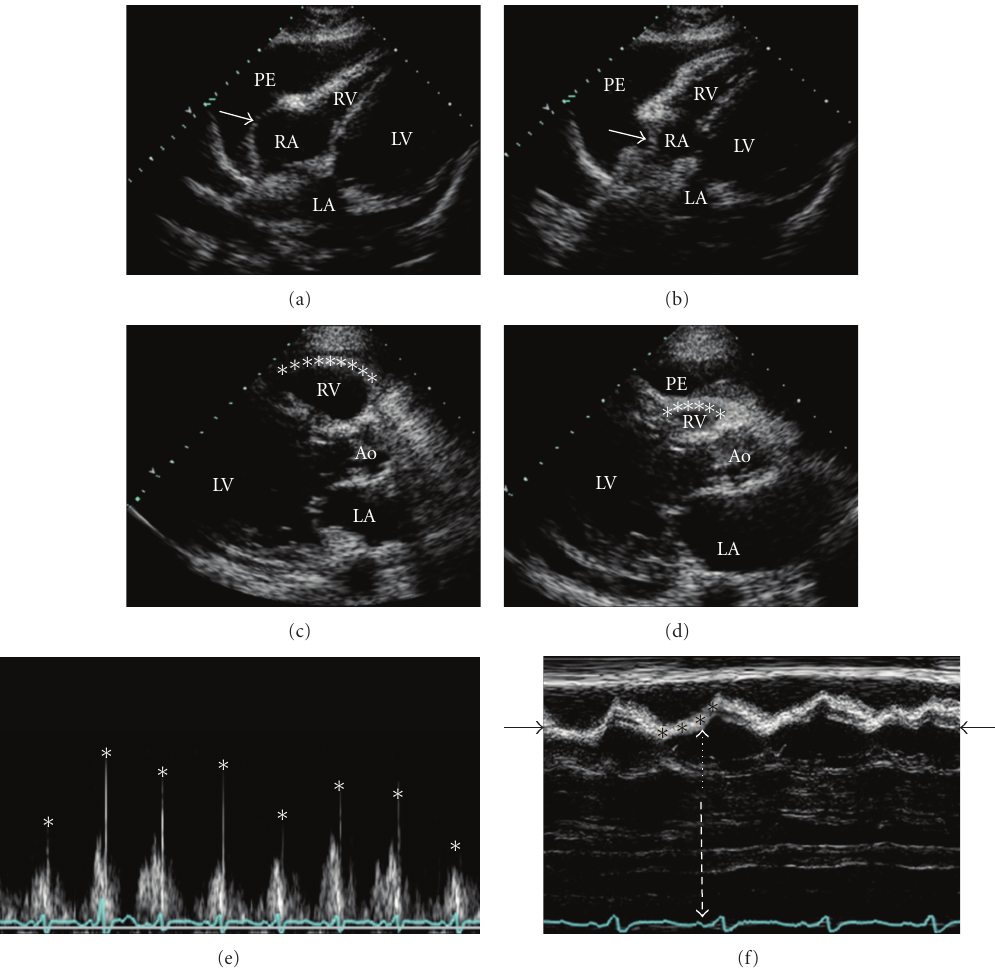
Figure 8: Echo signs of tamponade. Diastolic inversion of the right atrial (RA) free wall is an early sign of raised intrapericardial pressure ((a) and (b)), white arrow—note collapse/inversion of the RA free wall in early diastole (b) as the intrapericardial pressure exceeds the RA pressure. Right ventricular diastolic inversion is a later but more specific sign of tamponade ((c) and (d)) asterisks outline the RV free wall— the RV shows diastolic collapse (d) due to the adjacent e ff usion (PE). Note also the relative enlargement of the left ventricle (LV) in this case; a result of chemotherapy-related cardiomyopathy. Doppler techniques are often very helpful in establishing the diagnosis of tamponade— transtricuspid flow variability of greater than 33% on a beat-to-beat basis ((e), asterisks represent peak transtricuspid flow for each recorded beat) is suggestive of tamponade. M-mode Doppler has a very high sampling (frame) rate compared to standard B-mode Doppler and is therefore useful for timing the motion of the RV free wall with respect to the cardiac cycle ((f), horizontal white arrows indicate the RV free wall; as would be expected this moves in normally during systole but is slow to move outwards in early-to-mid diastole (black asterisks)—in fact full outward excursion only occurs late in diastole (dotted short arrow) aided by the filling from atrial contraction (dotted long arrow indicates P wave on ECG, i.e., atrial